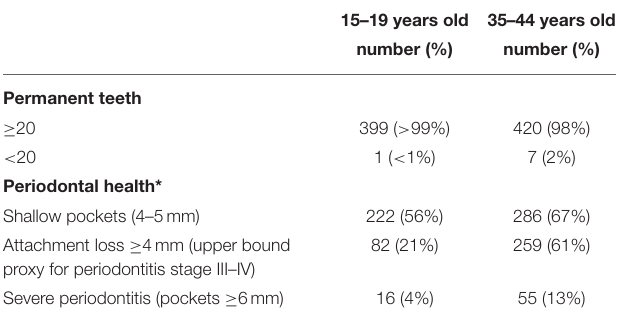
TABLE 3 | Percentage of individuals by select self-reported